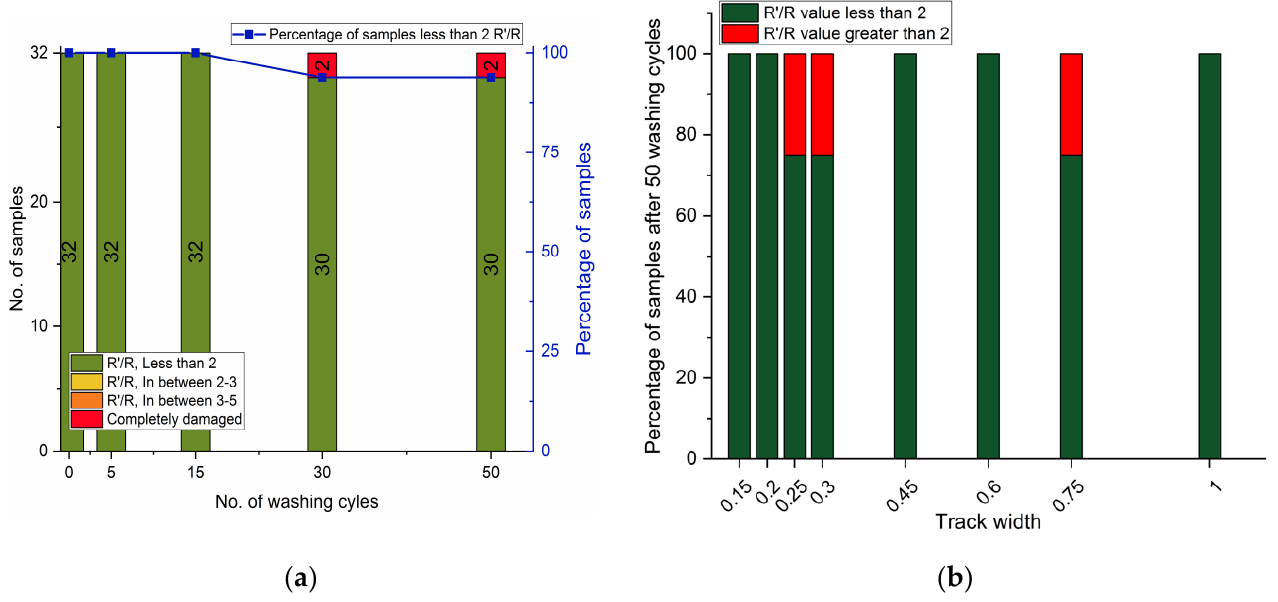
Figure 9. FPCB sample (with silicone protection completely) analyses after 50 Silk washing cycles, a total of 32 samples were tested: ( a ) No. of samples with R’/R values increased above 2, 3, and ultimately damaged pieces on the left y-axis and percentage of samples having R’/R value below 2 on the right y-axis; ( b ) ratio of samples having R’/R values below and above 2 after complete washing cycles based on track widths.